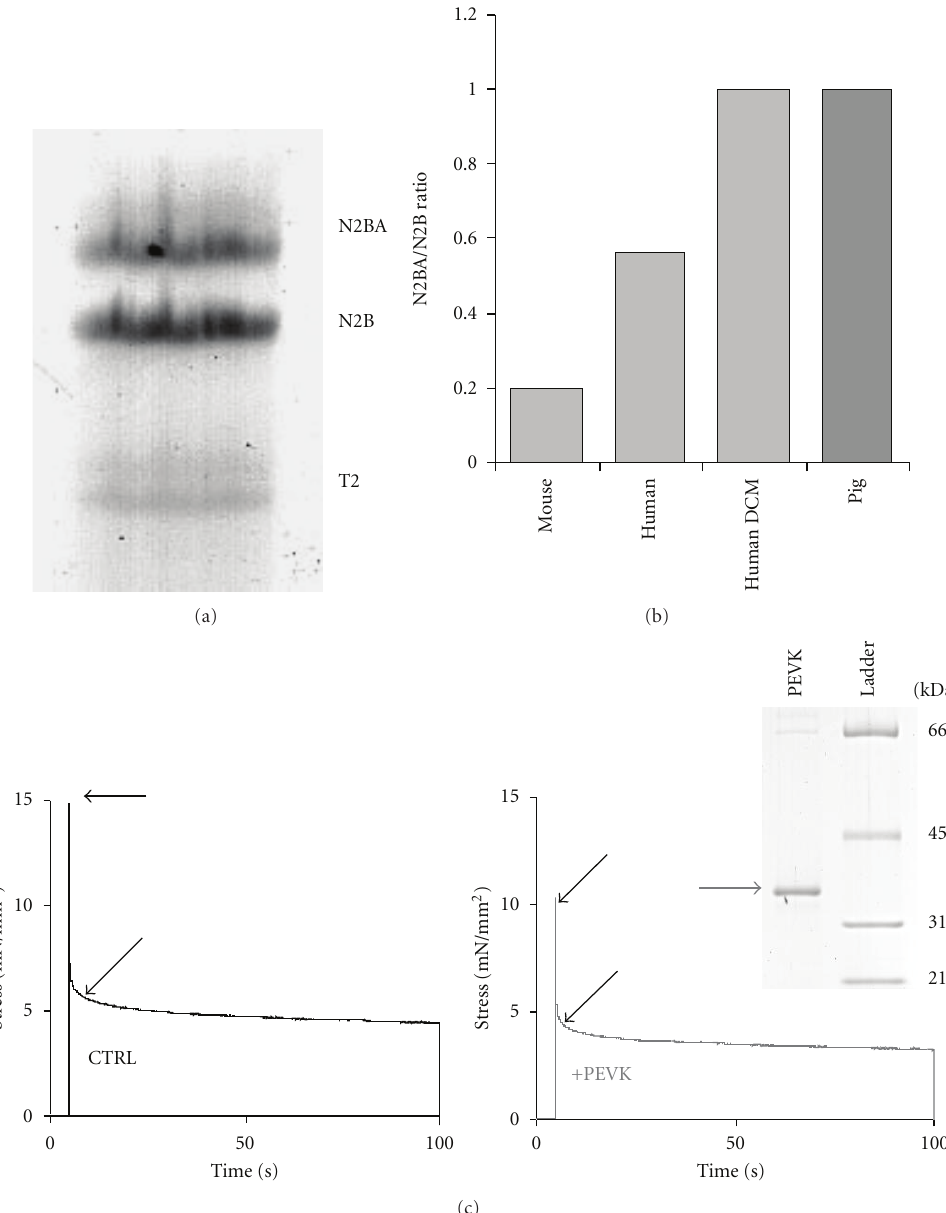
Figure 1: Porcine myocardial characteristics. (a) Pig LV tissues electrophoresed on a large pore 1% agarose gel indicate a nearly 1:1 N2BA:N2B ratio. (b) N2BA/N2B ratios range from 0.2 in small animals to 1.0 in human dilated cardiomyopathy (DCM). (c) Example mechanical perturbation of pig tissue from slack SL to 2.15 μ m at 10.0 lengths/s in control conditions and incubated with recombinant PEVK protein to inhibit native PEVK-actin interactions showing reduced stress relaxation (arrows). Inset: SDS-PAGE indicating the high purity of the recombinant PEVK protein fraction that was used. See text for